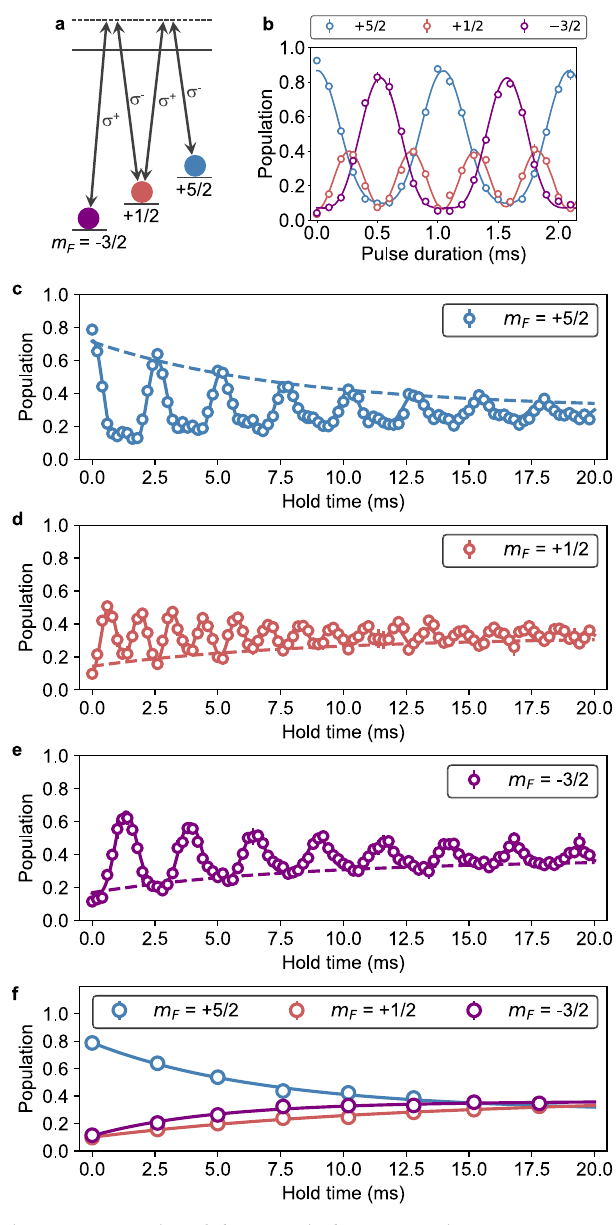
Fig. 6 Demonstration of three-terminal quantum spin transport. a Schematic representation of the 173 Yb nuclear spin states relevant to the experiment and the Raman transitions between the different (cid:1) (cid:3) (cid:1) m F mF states. b Raman Rabi oscillation of the three-level system. Error bars show the standard deviations of the mean values obtained by averaging three measurements. Solid lines represent fi ts to the data. c – e Time evolution of the relative population of the nuclear spin deviations of the mean values obtained by averaging three measurements. Solid lines represent fi ts to the data with the time constant fi xed to 80 ms, corresponding to the lifetime of the e j i atom in the three-terminal experiment. During the 40 ms hold time, the reduction of the total number of the g j i atoms is negligible. Dashed lines show the envelopes of the data fi ts as guides to the eye. Time evolution of the local maxima or minima of the oscillation shown in ( c – e ). Error bars are smaller than the symbol sizes. Solid lines represent guides to the